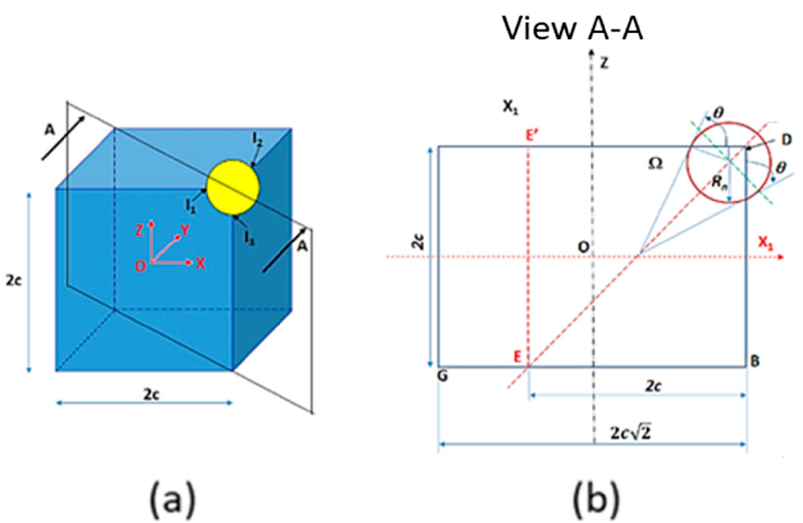
Figure 3. Scheme of the critical wettability angles, with a nucleus on the vertex of a cubic particle. ( a ) Case for θ < 45 ◦ . ( b ) Case for θ = 45 ◦ . ( c ) Case for θ > 45 ◦ .